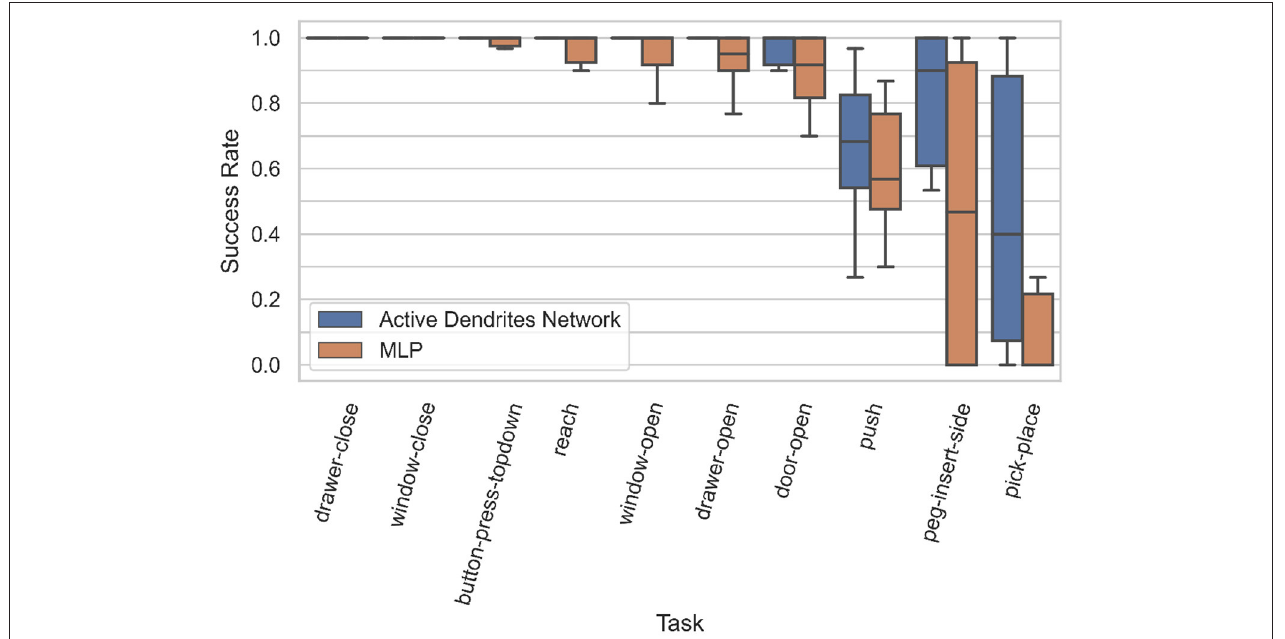
FIGURE 6 | Box plots of the accuracies for each MT10 task for our Active Dendrites Networks and MLP baseline networks in Experiment 1. We discard outliers for all runs for clarity.